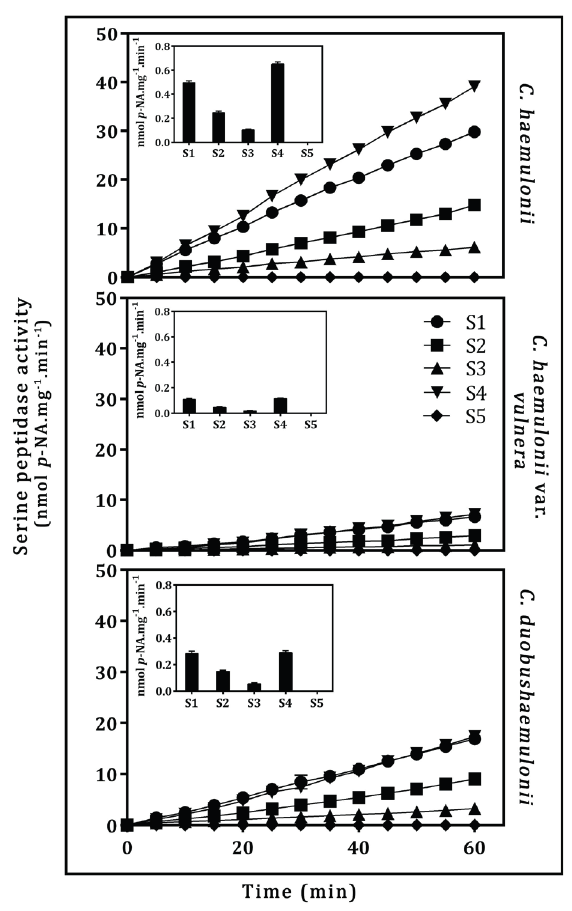
Figure 1 - Serine peptidase activities measured in the culture supernatants of clinical isolates of the C. haemulonii complex. the serine peptidase activities were evaluated during 60 min of incubation at pH 7.0 and 37°C. Five substrates were used: